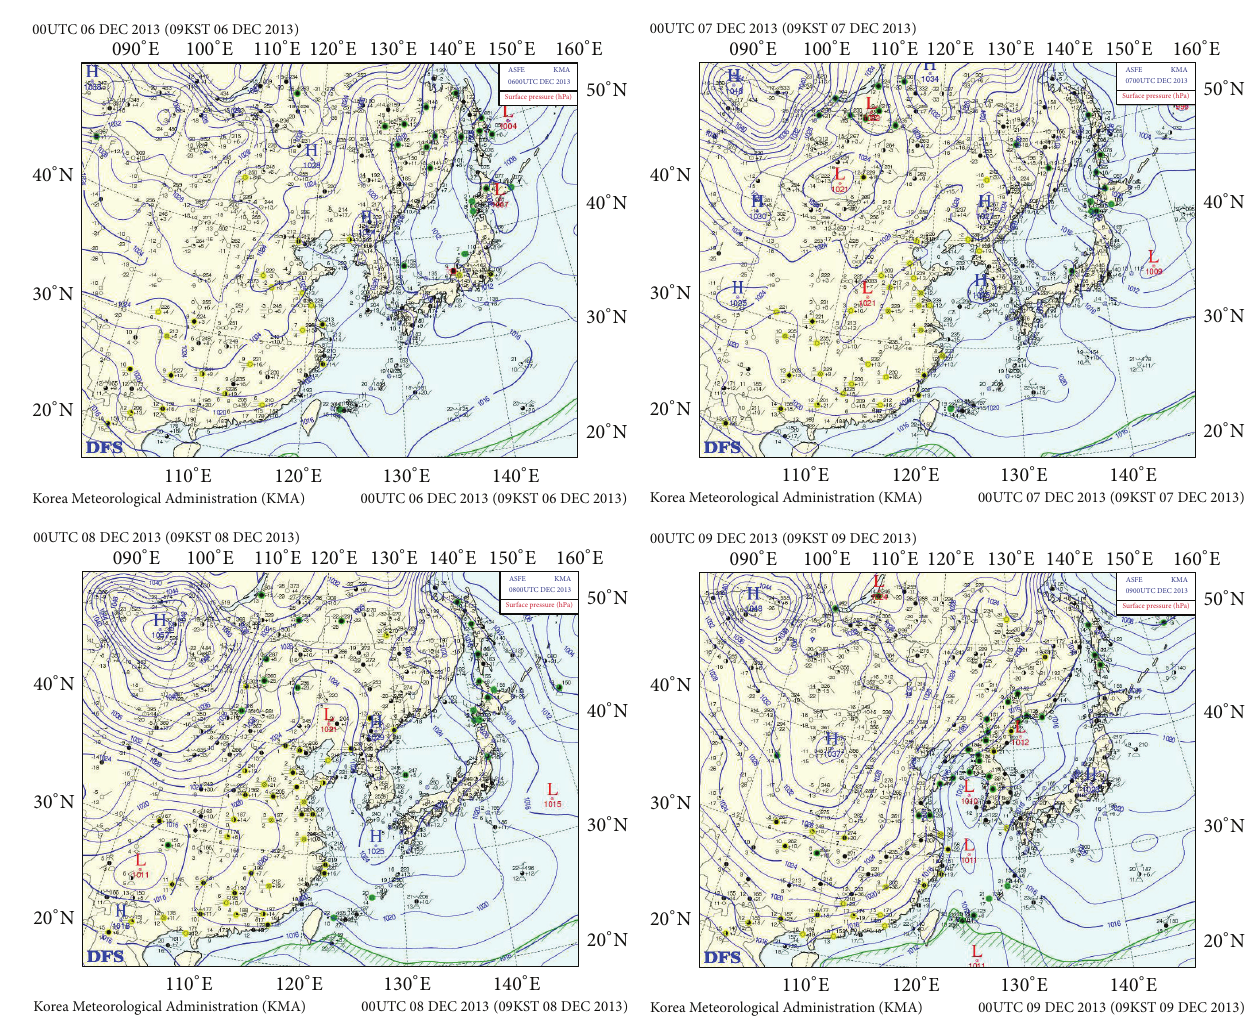
Figure 7: Surface weather patterns over eastern Asia at 08:00 (local time) on 6, 7, 8, and 9 Dec. 2013 (from http://web.kma.go.kr/).